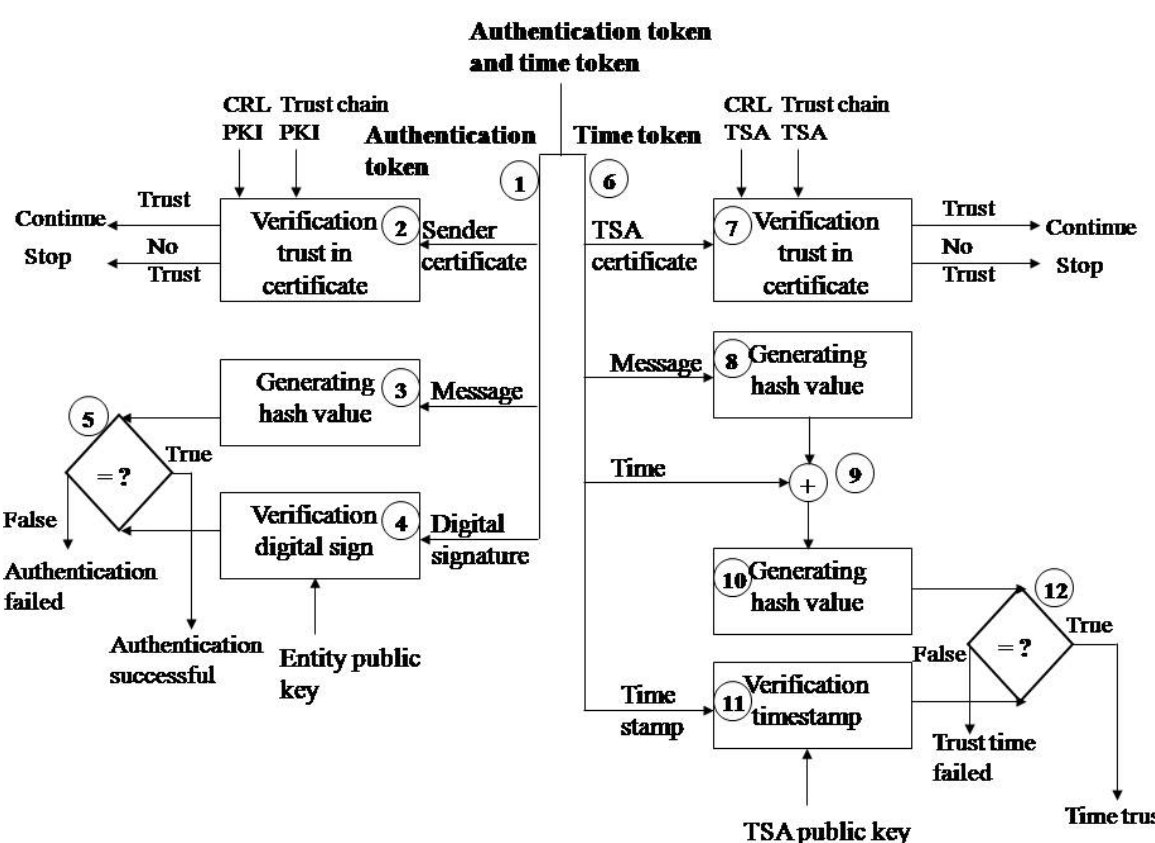
Figure 3. Verification of the authentication token and time token.